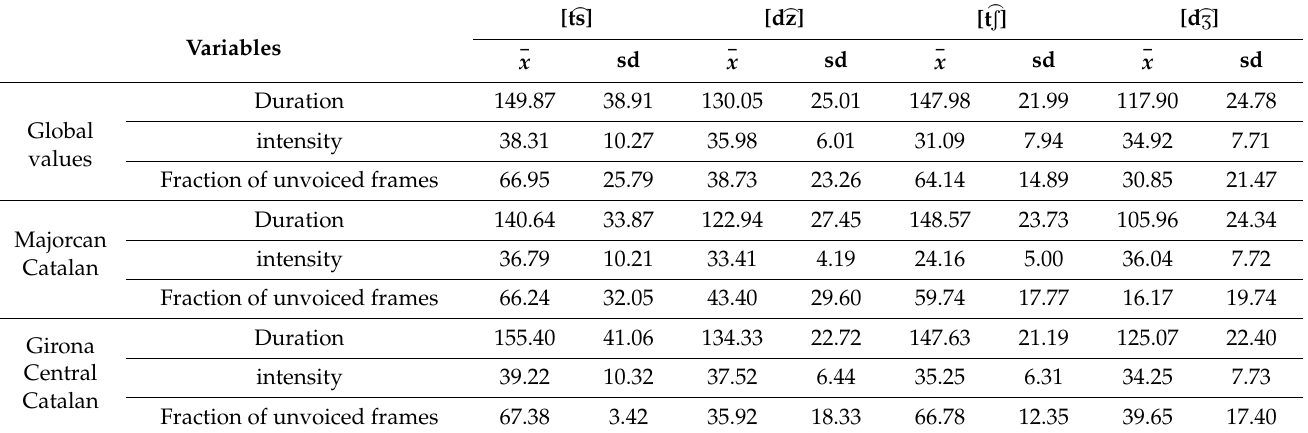
Table 5. Mean value and standard deviation for the dependent variables. Duration values are offered in milliseconds, intensity in decibels, and fraction of unvoiced frames is presented as a percentage of the sound’s